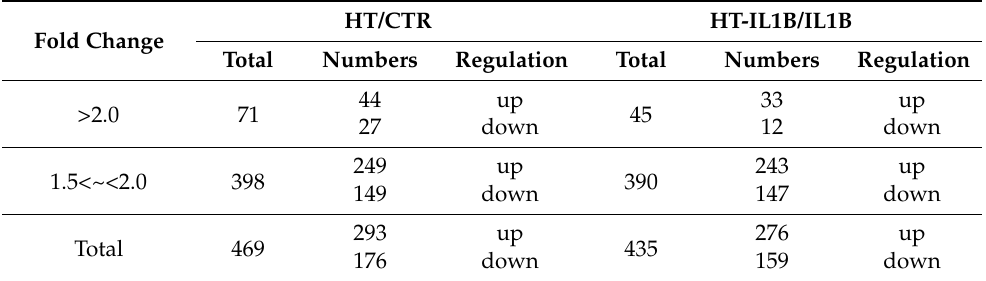
Table 2. Gene expression profiling of HT treated endothelial cells by IPA analysis. HT/CTR HT-IL1B/IL1B Fold Change Total Numbers Regulation Total Numbers Regulation >2.0 71